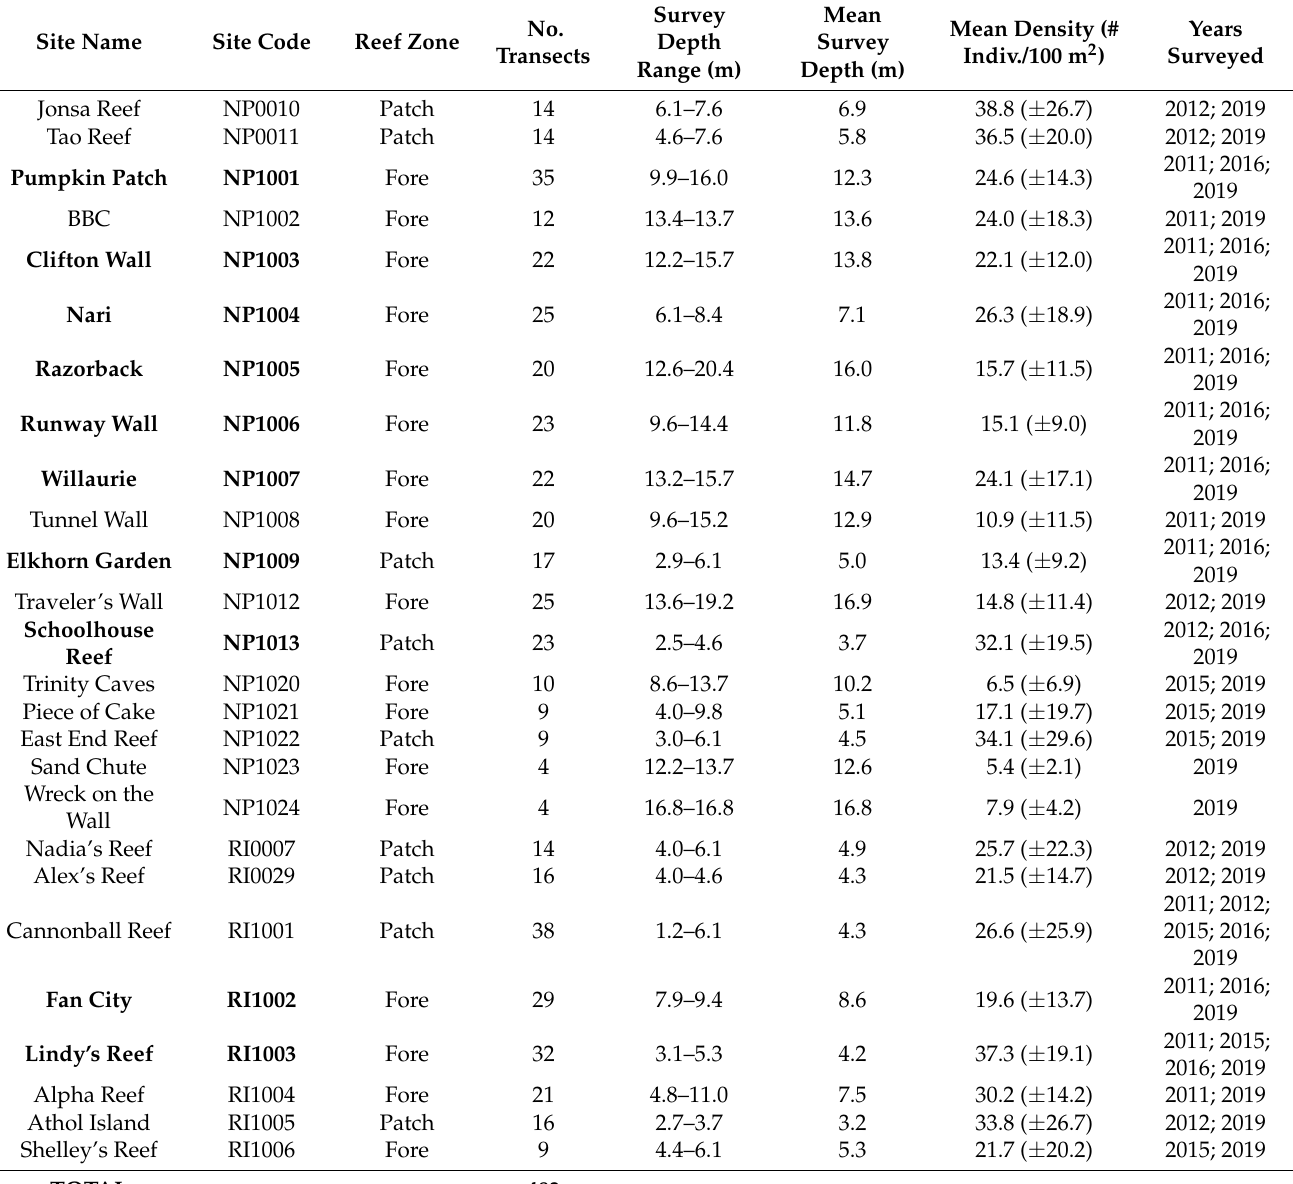
Table 1. Summary information for the number of fish transects, depth ranges and mean survey depth in meters and mean parrotfish density (number (#) of individuals per 100 m 2 ) ± standard deviation (SD) for each site surveyed around New Providence and Rose Island between 2011 and 2019. The 10 sites repeatedly surveyed across all three survey periods are highlighted in